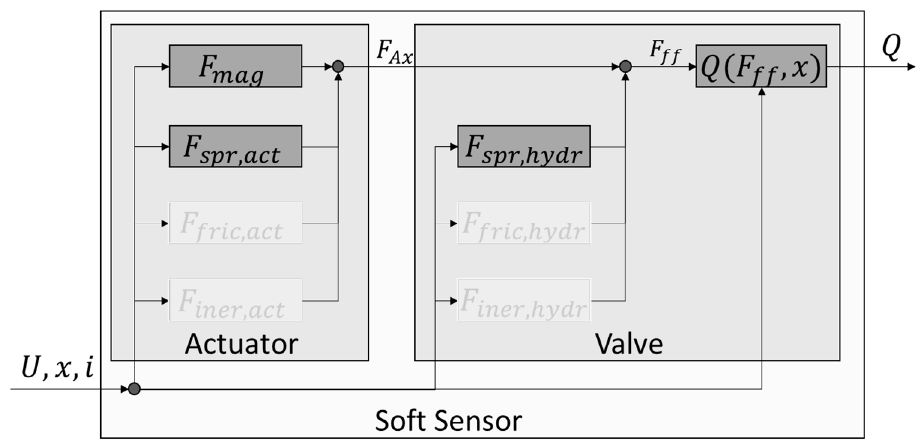
Figure 4. Simplified Soft Sensor Model.